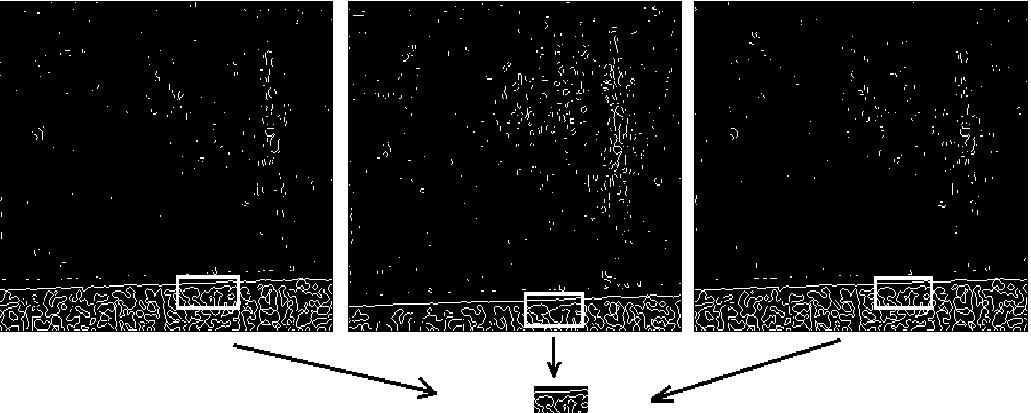
Figure 2: Implementation of the motion compensation algorithm for the temperature contour